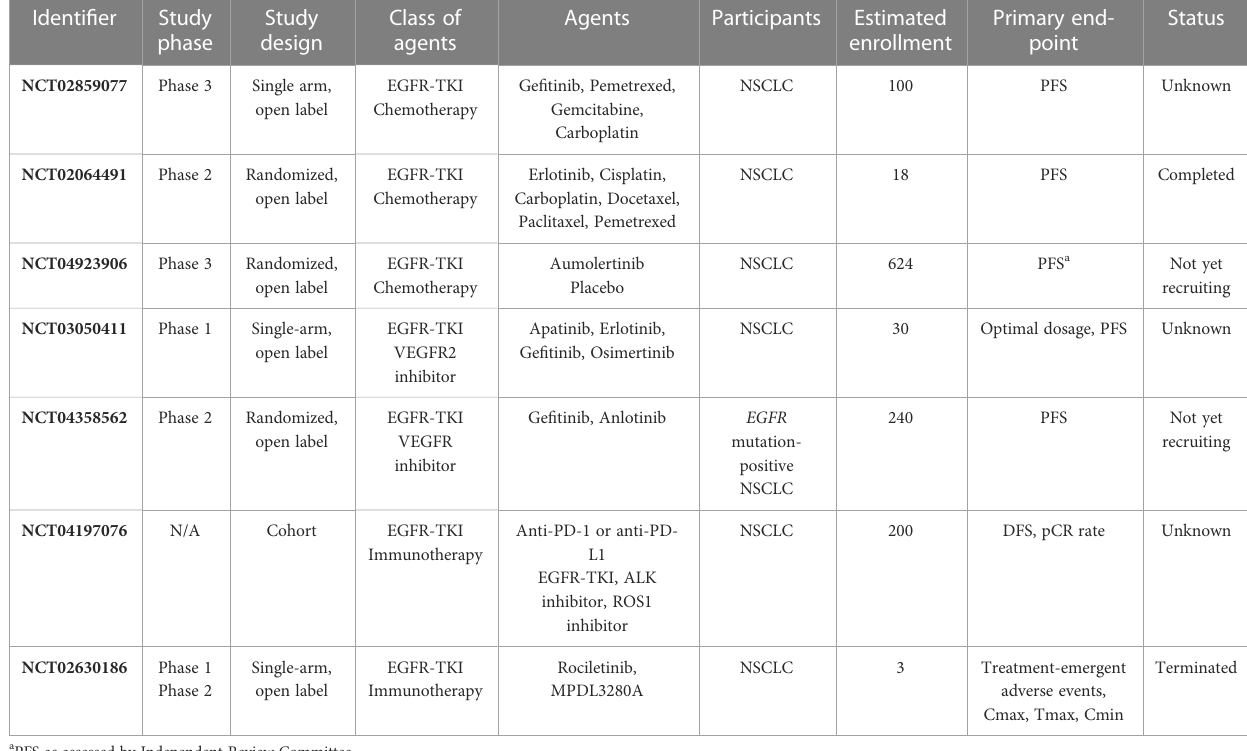
TABLE 1 Clinical trials studying EGFR-TKI-based combination regimens in the NSCLC. Identi fi